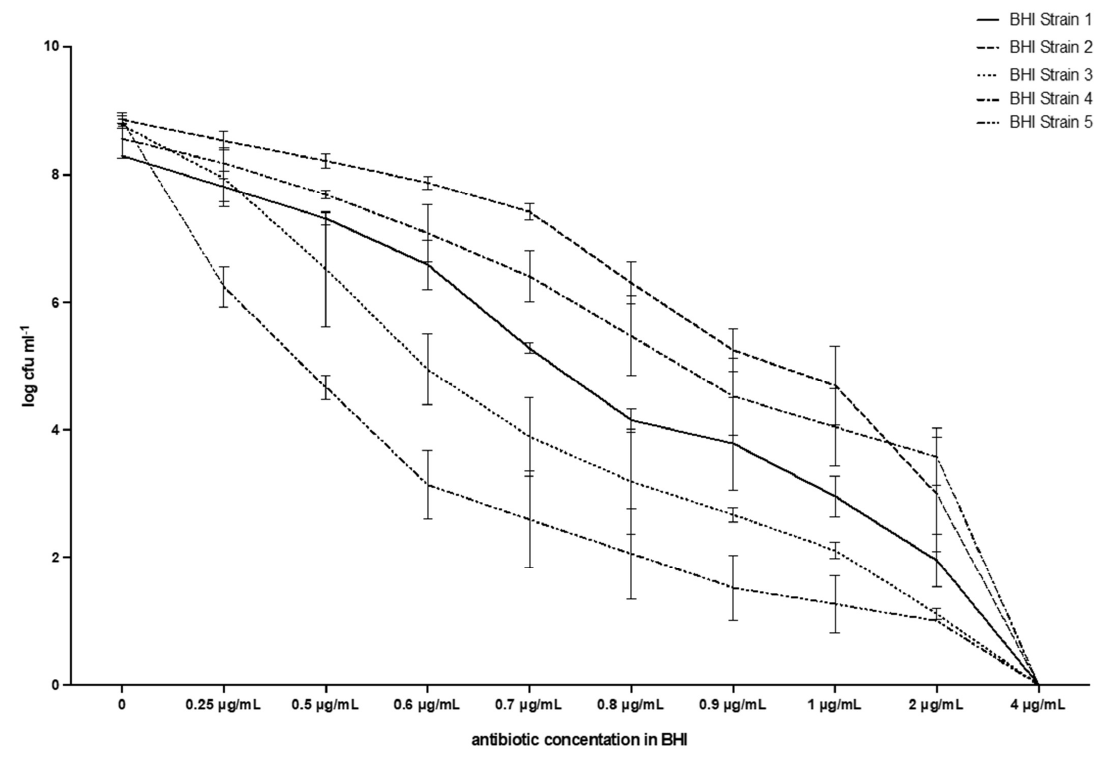
Figure 3. Breakpoint and evolution of the five strains of E. casseliflavus tested with the method described in this work. BHI.